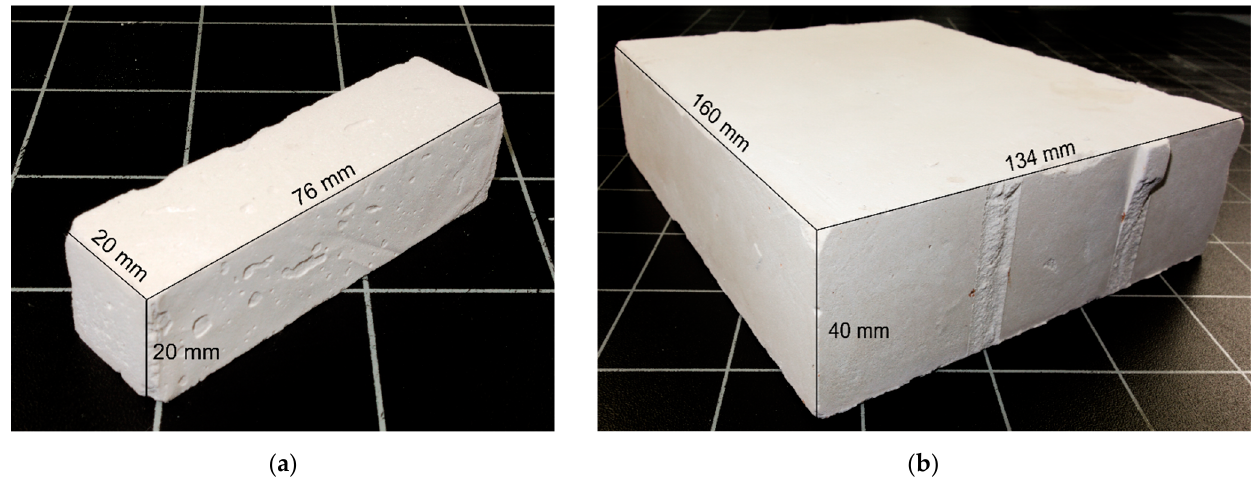
Figure 1. Specimen with 50 wt.% CSA cement (50C) after 14 days of hydration: ( a ) small prism; ( b ) big prism.